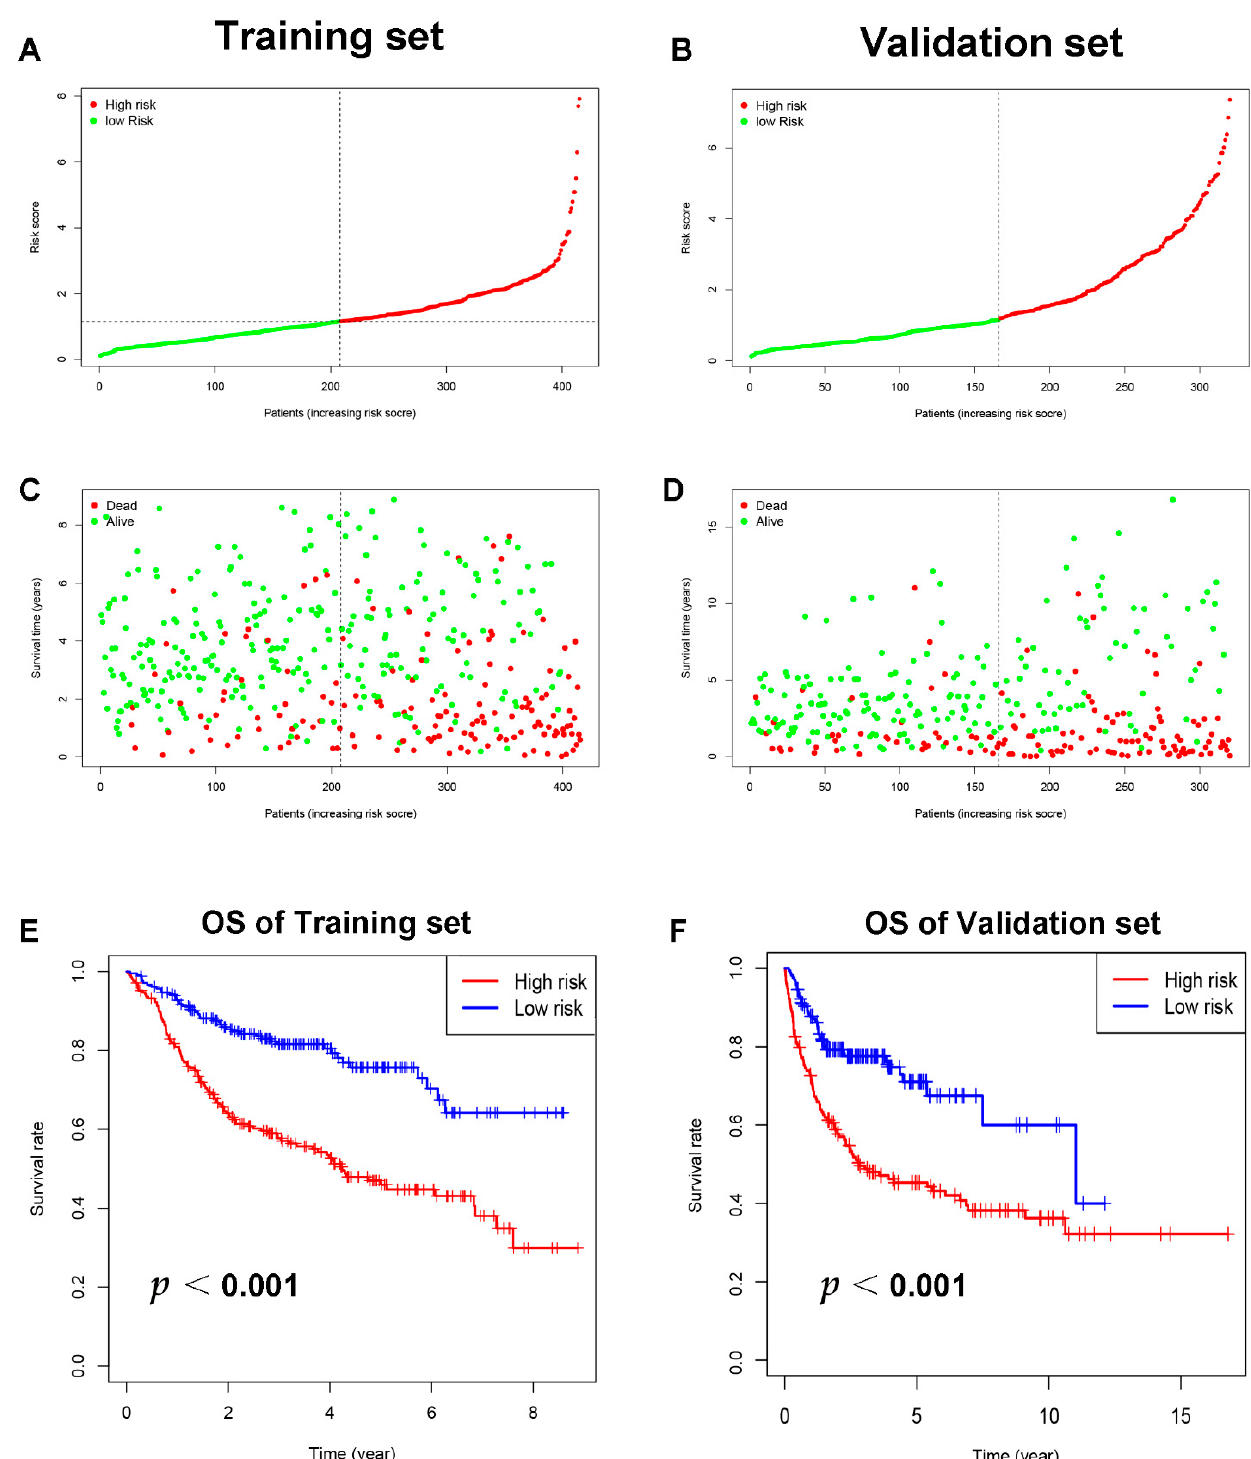
Figure 3. The training and validation sets’ relationships between ICD-related gene signature and prognosis. ( A ) The training set distribution of risk score and ( B ) that for the validation set. Survival status, overall survival, and distributions of training set risk score ( C ) and validation set risk score ( D ). Kaplan–Meier graphs illustrate the differences in OS among low-risk and high-risk groups in both the training ( E ) and validation sets ( F ). Abbreviations: OS, overall survival.